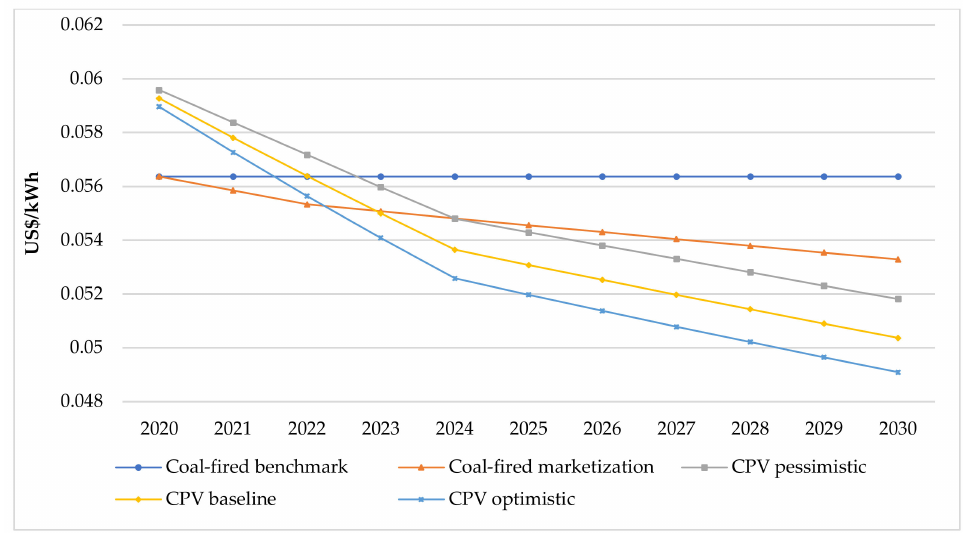
Figure 9. Cost comparison under Scenario 2.